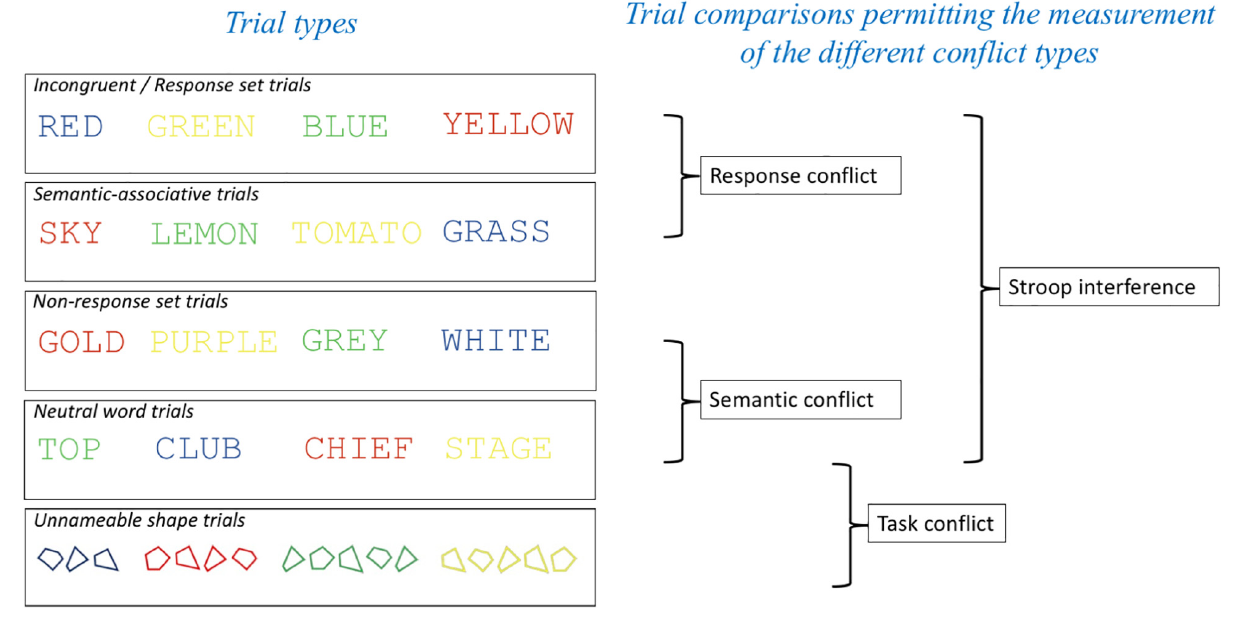
30 slices, TR = 2300 ms), normalized and smoothed (to 8 mm).